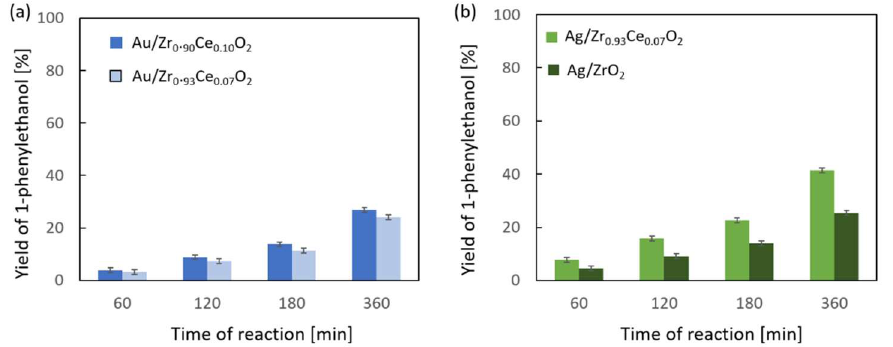
Figure 7. Activity test results of catalysts supported on cerium-doped zirconia: yield of 1-phenylethanol obtained during catalytic transfer hydrogenation of acetophenone with 2-pentanol in the presence of ( a ) Au/ZC and ( b ) Ag/ZC.